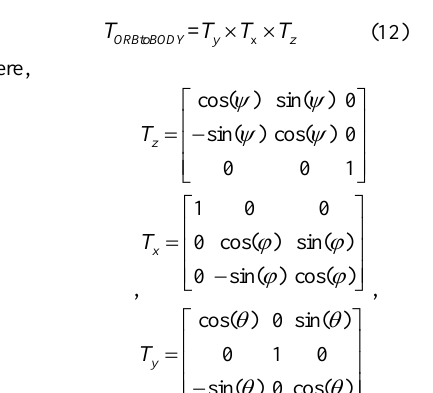
Figure 1. The angle between the solar orientation vector and the Y axis of the sensor coordinate system during a period of time Figure 2 shows the curves of the angle between the solar orientation vector and the X-axis in the sensor coordinate system for a period of time when the ultraviolet forward spectrometer directly observes the sun.